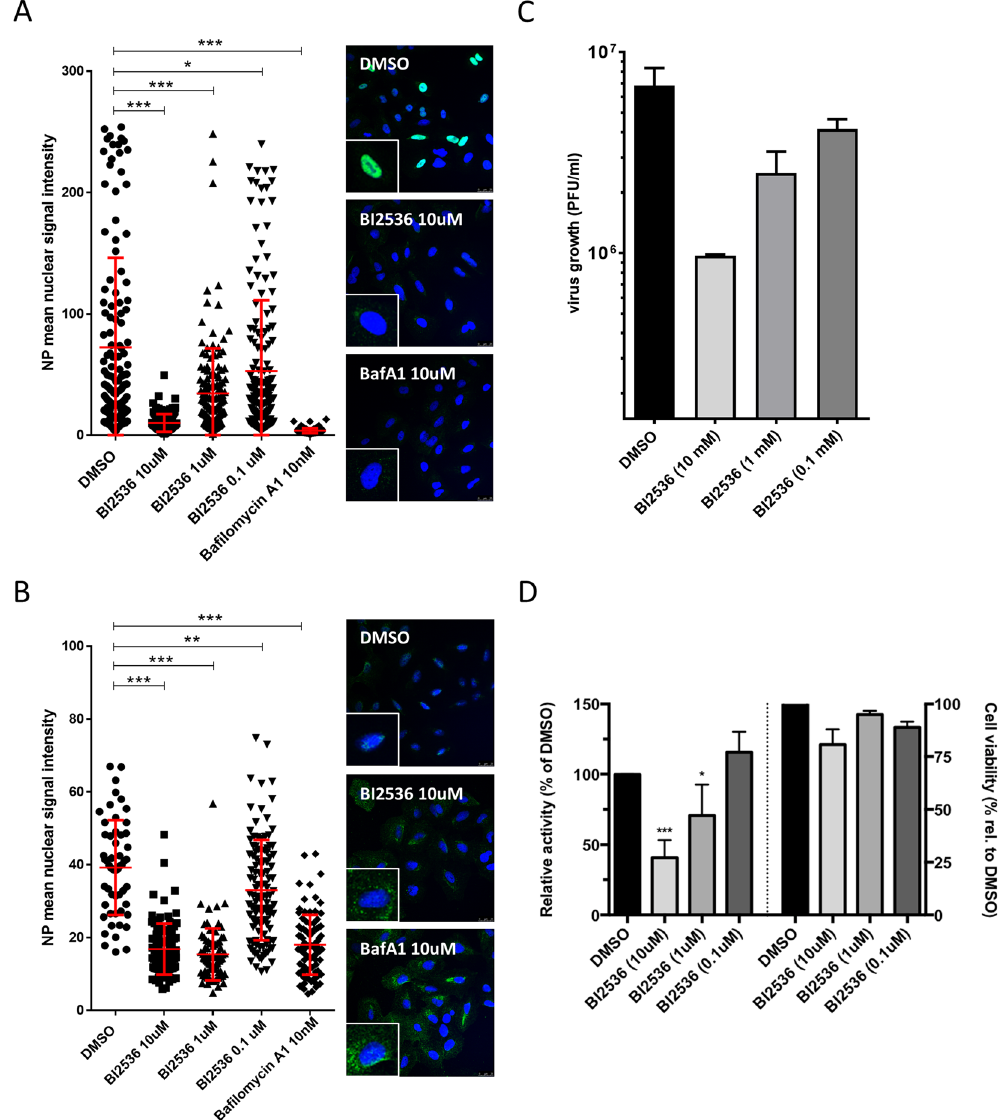
Figure 3. PLKs are required early in the infectious cycle. ( A ) Inhibition of PLKs leads to decreased nuclear NP signal at 3 h post infection. A549 cells were treated with indicated amounts of BI2536 or DMSO for 2 h. Cells were infected with WSN at MOI 10 for 1 h on ice with inhibitor/DMSO present in the tissue culture medium. After infection, cells were washed and then incubated with inhibitor-containing medium for 3 h at 37 °C. Then, cells were fixed and stained for NP (green) and DNA (blue). Images were acquired on a Leica SP5 confocal microscope and NP mean nuclear signal intensity was quantified using ImageJ software. Shown is one representative experiment out of three independent experiments; error bars indicate standard deviation. Statistical significance of differences between DMSO and the inhibitors was determined using the Mann Whitney test ( * P < 0.05, *** P < 0.001). ( B ) Inhibition of PLKs leads to decreased nuclear accumulation of incoming vRNPs. Same experimental set-up as in ( A ) but CHX (100 mg/ml) was present in the tissue culture medium. Statistical significance of differences between DMSO and the inhibitors was determined using the Mann Whitney test ( ** P ≤ 0.005, *** P < 0.001). ( C ) Inhibitor treatment early in infection reduces IAV replication. A549 cells were pre-treated with inhibitor-containing medium at the indicated concentrations for 1 h at 37 °C. Then, cells were infected with A/WSN/33 at MOI 1, diluted in inhibitor-containing medium for 1 h at 37 °C. After infection, cells were washed and treated with inhibitor-containing medium for additional 2 h at 37 °C. Then, cells were kept in inhibitor-free medium for 14 h. At 17 h pi, tissue culture supernatants were harvested and viral growth was determined by plaque assay. Shown are averages of three independent experiments, each performed in duplicates, with standard deviation. ( D ) Inhibition of PLKs impacts IAV polymerase activity. HEK293T cells were used for IAV RNP reconstitution. Six hours after transfection, medium was changed and DMSO or the indicated concentrations of BI2536 were added. After 18 hours cells were harvested and luciferase activities were assayed (left Y-axis). In parallel, untransfected cells were treated